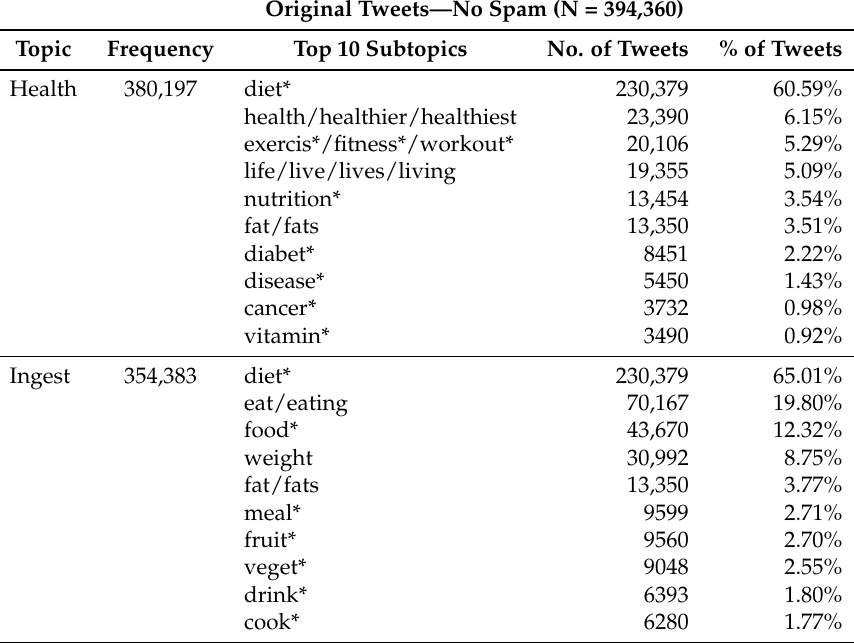
Table 8. Summary of Prominent Sub-topics in Original Tweets by the All Accounts Excluding Verified and Spam Accounts.